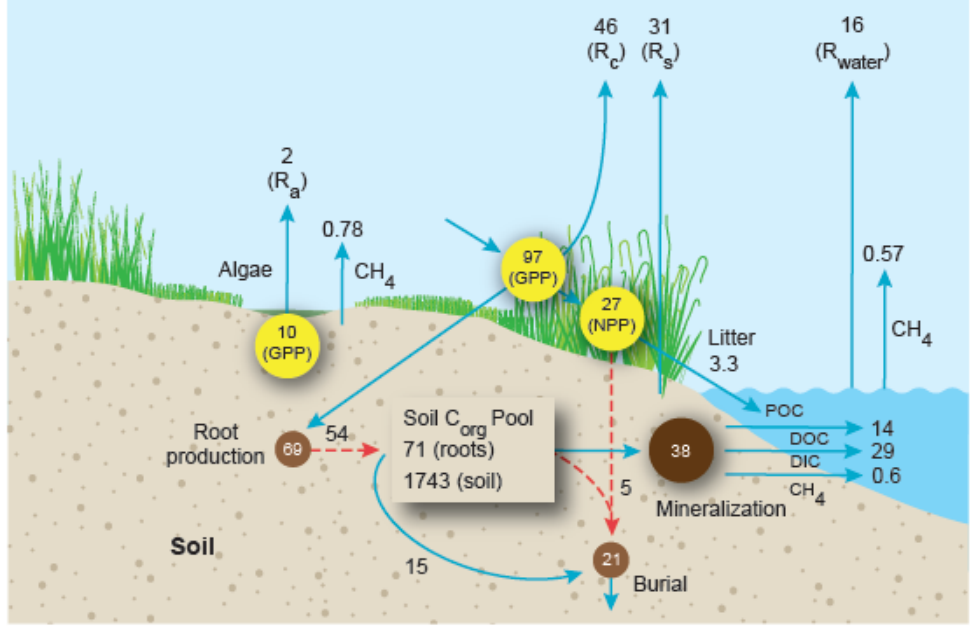
Figure 4. Mass balance of mean carbon flow through the world’s salt marshes. Units are Tg C a − 1 . The budget assumes a global salt marsh area of 54,951 km 2 [49]. Solid blue arrows depict mean values based on empirical data (see text for explanation and references). Dashed red arrows represent mean values estimated indirectly by difference. The C ORG pool (both live and dead roots and other organic matter) in soils to a depth of 1 m is presented in a box in the marsh floor with units of Tg C ORG . Abbreviations: GPP = gross primary production; NPP = net primary production; R A = algal production at soil surface and aboveground biomass; Rc = canopy respiration; R S = soil respiration at soil surface; R WATER = waterway respiration; POC = particulate organic carbon derived from litter and exported to tidal waters; DIC = dissolved inorganic carbon; DOC = dissolved organic carbon; CH 4 = methane.